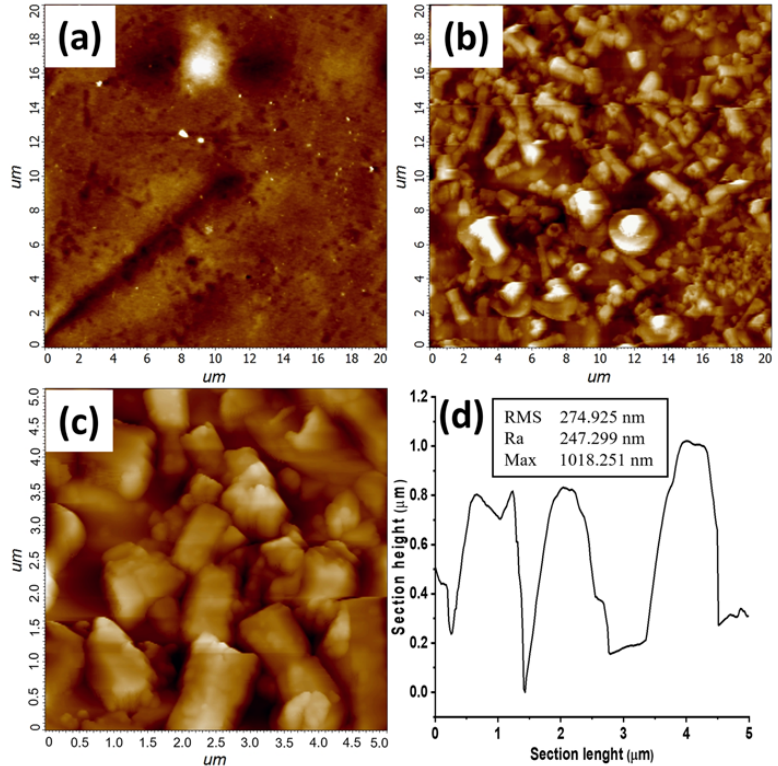
Figure 6. AFM images of the PDMS-ZnO surface: scale bar 20 × 20 µm 2 ( a ), and 5 × 5 µm 2 ( b ); 20 × 20 µm 2 AFM image of bare PDMS surface ( c ); section analysis and topographical information ( d ). Related topographical information, expressed in terms of roughness (root mean square (RMS) and mean heights (Ra)) and maximal heights of the structures [38], are reported in Figure 6d. Mean lateral particle dimensions, estimated by ImageJ software, were 1.6 µm, with a minimum value of 670 nm and a maximum value of 2.5 µm. The presence of ZnO inside the microchannel on the PDMS surface was also confirmed by XPS analysis. Table 1 shows the XPS atomic concentration analysis for two representative PDMS and ZnO-PDMS devices. Table 1. XPS atomic concentration analysis for two representative PDMS and ZnO-PDMS mofd devices. Sample